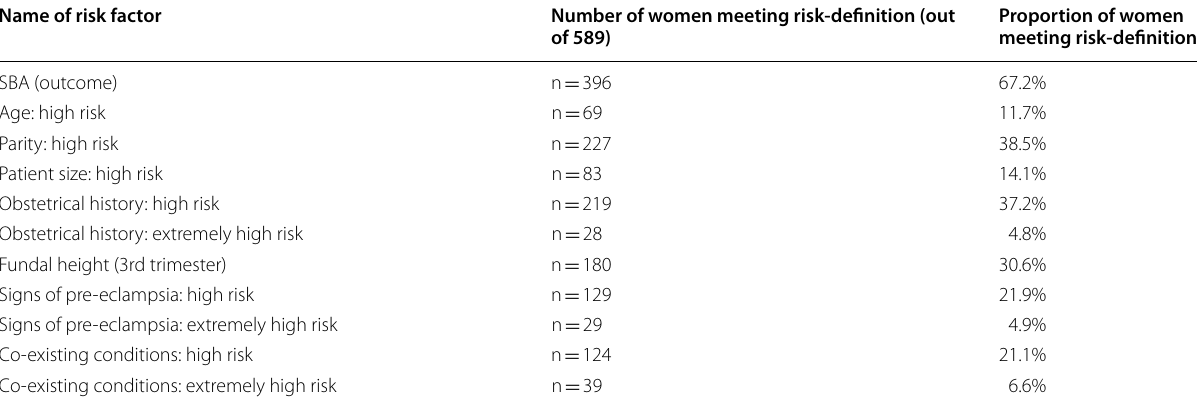
Table 2 Frequency distribution of the 7 risk factors included in the CMDS based on 589 women who delivered at the Federal Medical Centre, Makurdi, Nigeria